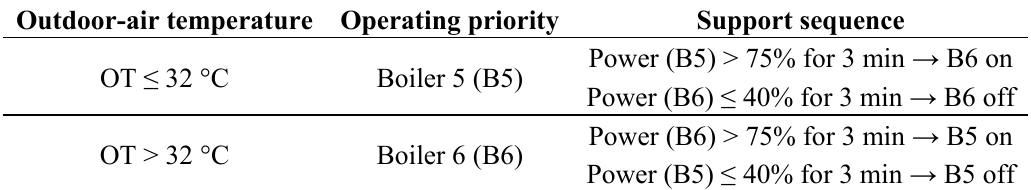
Table 2. Boilers 5 and 6: Control